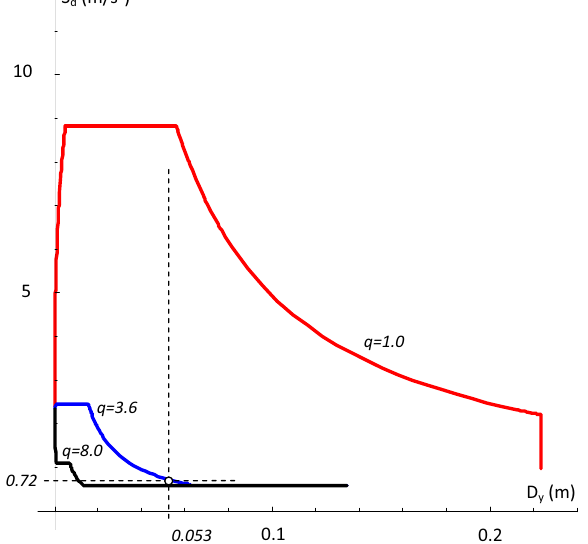
Fig. 12 Yield Point Spectra representation of EC-8 Design